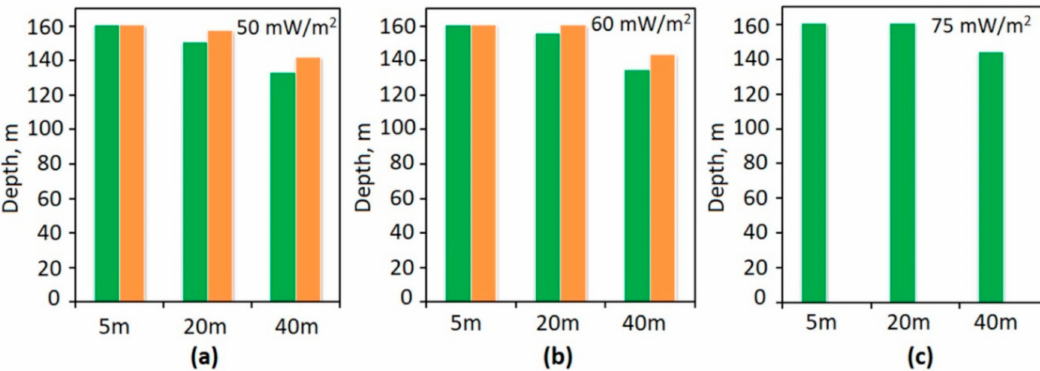
Figure 11. The upper boundary of the GHSZ under the extraglacial (green bars) and glacial (orange bars) conditions on 5, 20, and 40 m isobaths. Modeling results for the recent period with the heat flux: